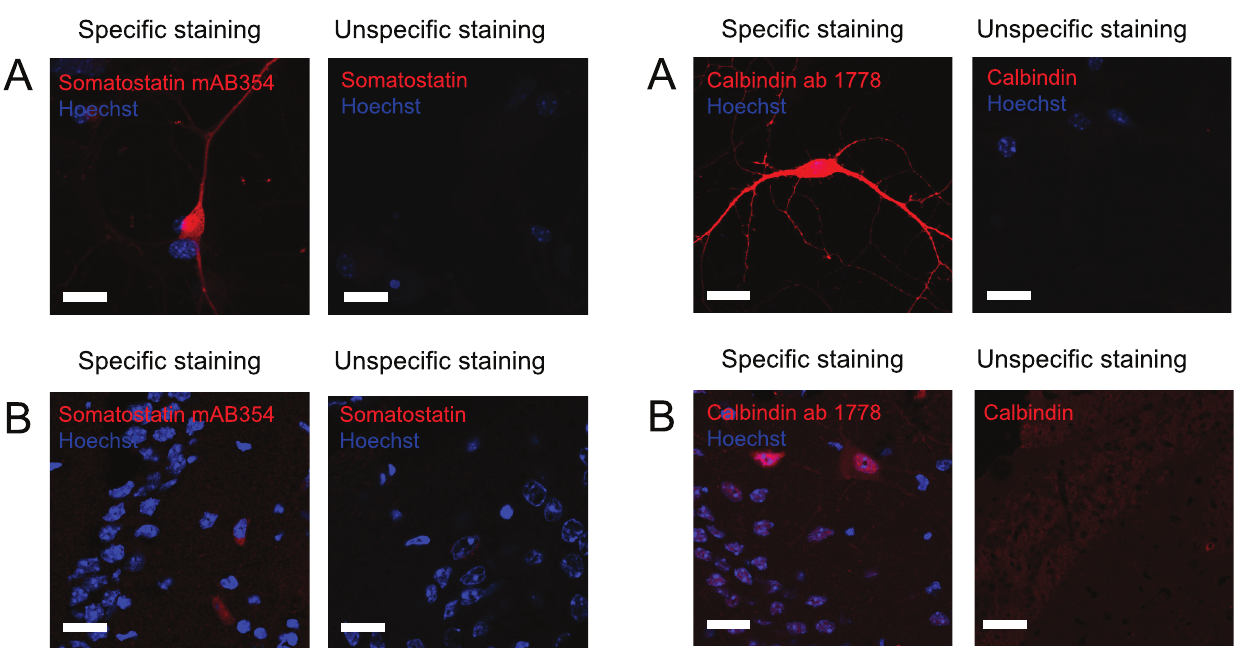
Figure 3. Staining against somatostatin. Figure 3 shows immunostaining against somatostatin on A ) cultured hippocampal neurons and B ) hippocampal tissue. Left pictures shows an example of an immunostaining considered to be specific while right picture shows an example where immunostaining using other primary antibodies did not meet the criteria and therefore was considered unspecific. Scale bar represents 20 μm.